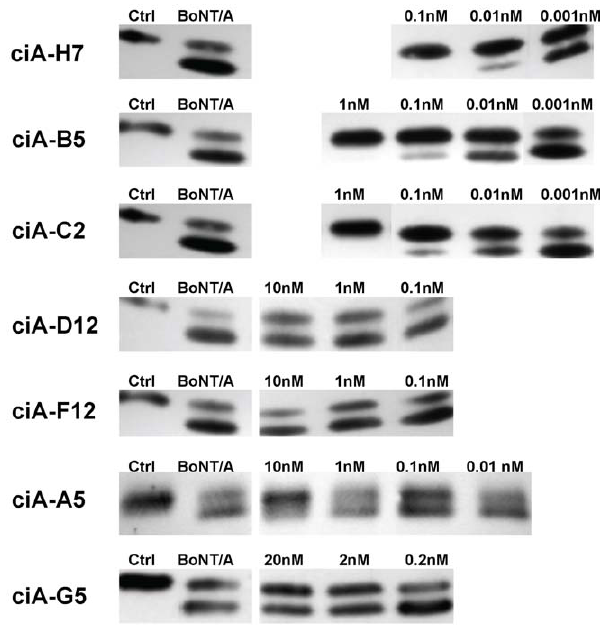
Figure 1. VHH neutralization of BoNT/A in rat primary cerebellar neuron cultures. Purified anti-BoNT/A VHHs (ciA-) were added to the medium for cultured primary cerebellar neurons at the indicated concentrations and then BoNT/A ( , 10 pM) or medium (Ctrl) was added. After overnight culture, the cells were harvested and the extent of SNAP25 cleavage was assessed by Western blot. The upper band represents uncleaved SNAP25 while the lower band is BoNT/A cleaved SNAP25. VHHs that clearly inhibited BoNT/A cleavage of SNAP25 at concentrations of 0.1 nM were considered to be strong neutralizing agents (Table 1). Data shown for each VHH were obtained within the same experiment and are representative of at least two independent